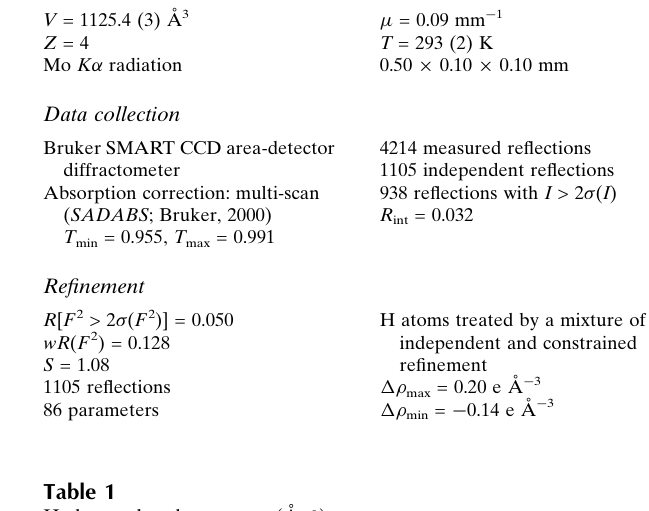
Hydrogen-bond geometry (A˚ , (cid:1)